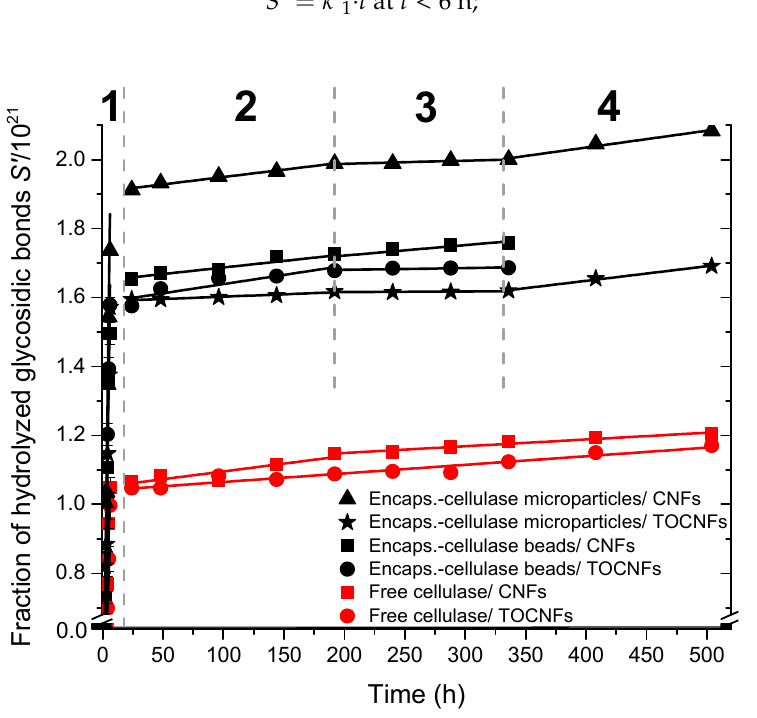
Figure 8. Evolution of the fraction of hydrolyzed glycosidic bonds S ′ with the hydrolysis time during the enzymatic degradation of cellulose nanofibers CNFs and TOCNFs, by the cellulase immobilized in the alginate beads or microparticles in comparison to the free enzyme; at maximum enzyme activity conditions (pH 4.8, T = 55 ◦ C). With the free cellulase, two degradation regimes (1 and 2) were observed for TOCNFs hydrolysis (- • -) and three regimes (1, 2, 3) for CNFs hydrolysis (- (cid:4) -). With the cellulase immobilized in the alginate beads, three regimes were observed until 336 h (14 d) (- (cid:4) -: CNFs; - • -: TOCNFs). With the cellulase immobilized in the alginate microparticles, four regimes (1, 2, 3, and 4) were observed until 504 h (21 d) (- (cid:78) -: CNFs; -*-: